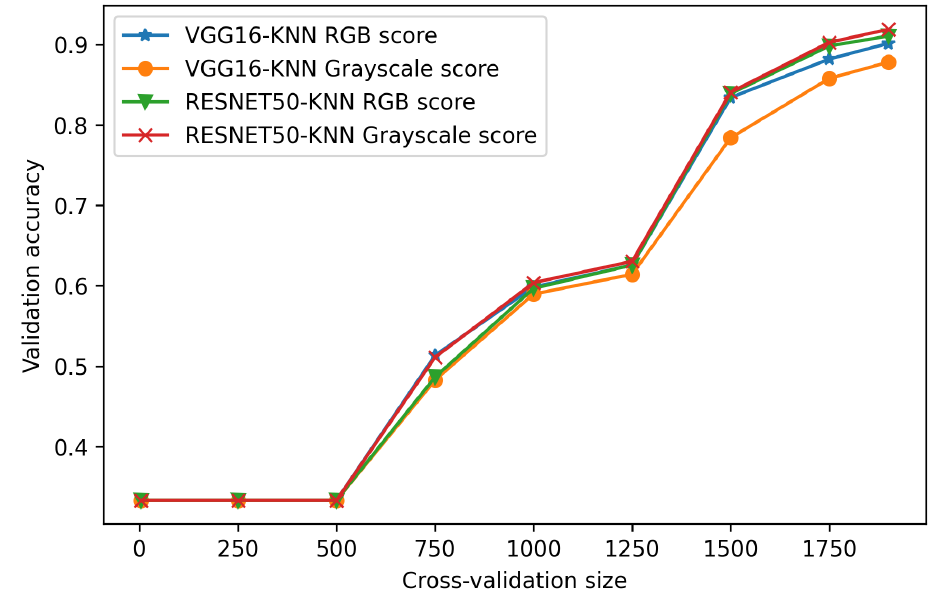
Figure 9. Comparison of cross-validation accuracy of VGG16-kNN and ResNet50-kNN models trained by RGB and greyscale